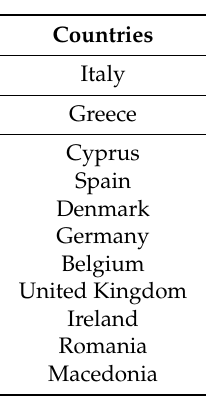
Table 1. Research